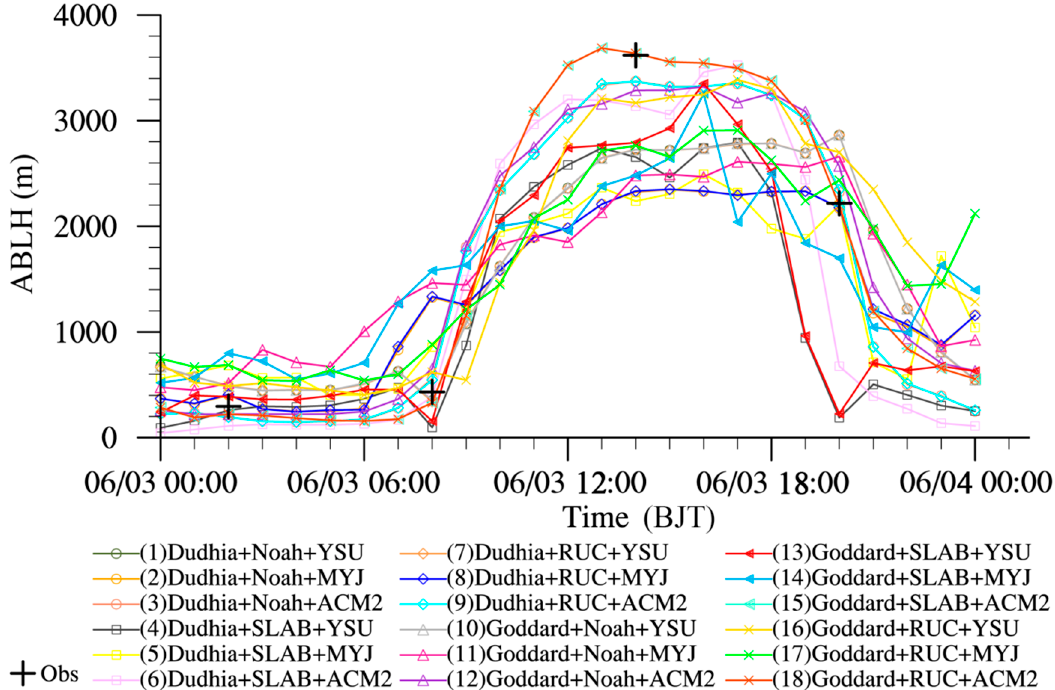
Figure 9. Numerical simulation of Jiuquan using different combinations of parameterization schemes and calculation of boundary layer heights with ERA-Interim model level data from 16:00 on 2 June, 2016, to 16:00 on 3 June, 2016.